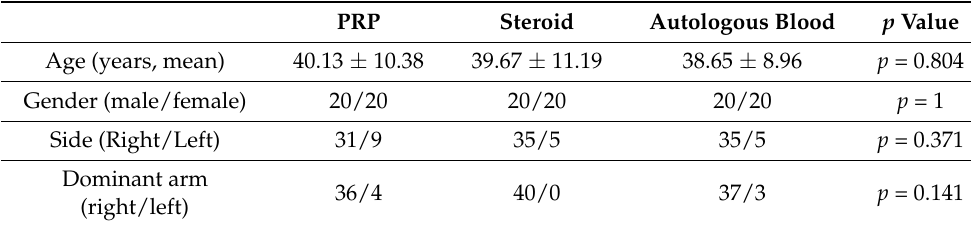
Table 1. Distribution of patients by age, gender, affected arm, and dominant arm. PRP Steroid Autologous Blood p Value Age (years, mean) 40.13 ± 10.38 39.67 ± 11.19 38.65 ± 8.96 p = 0.804 Gender (male/female) 20/20 20/20 20/20 p = 1 Side (Right/Left) 31/9 35/5 35/5 p = 0.371 Dominant arm 36/4 40/0 37/3 p = 0.141 (right/left)